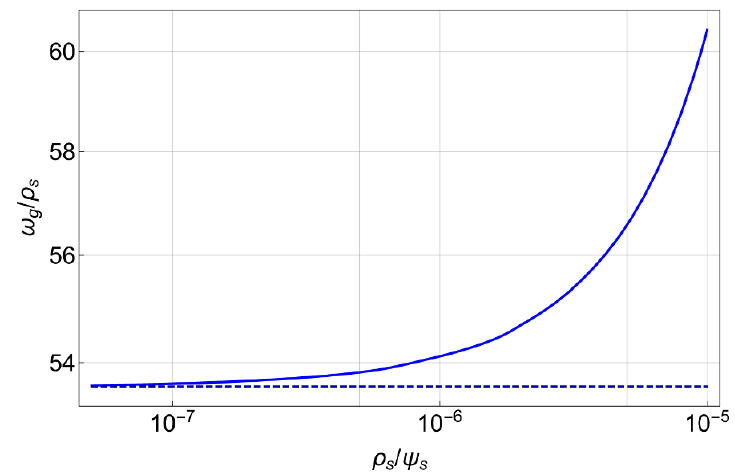
Figure 6 . Plot of the gap ! g as a function of the pinning parameter (cid:14)(cid:26) s